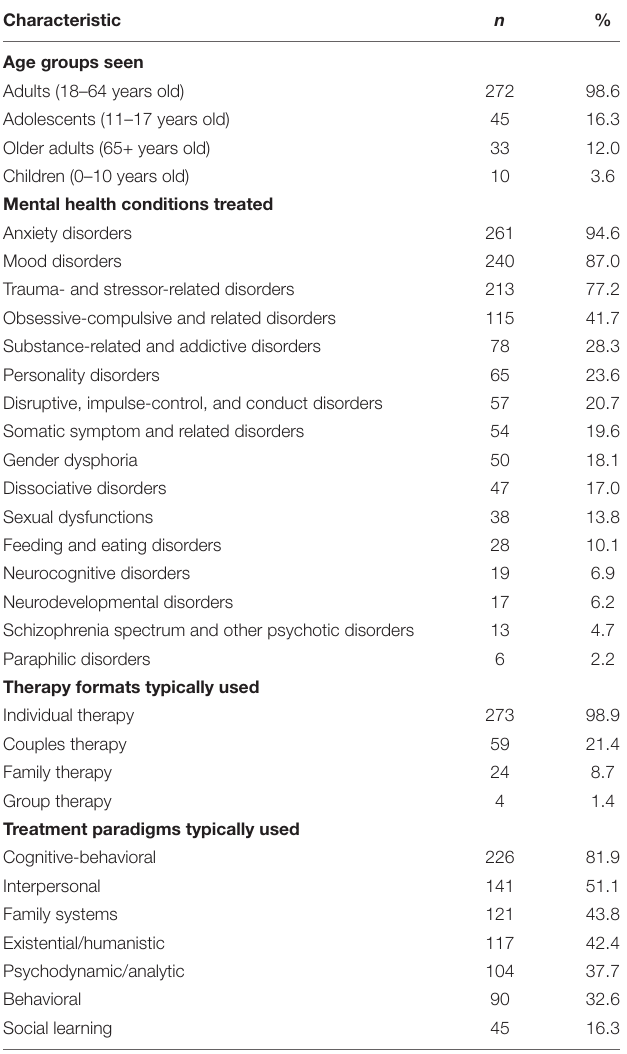
TABLE 1 | Characteristics of telemental health caseload and treatment